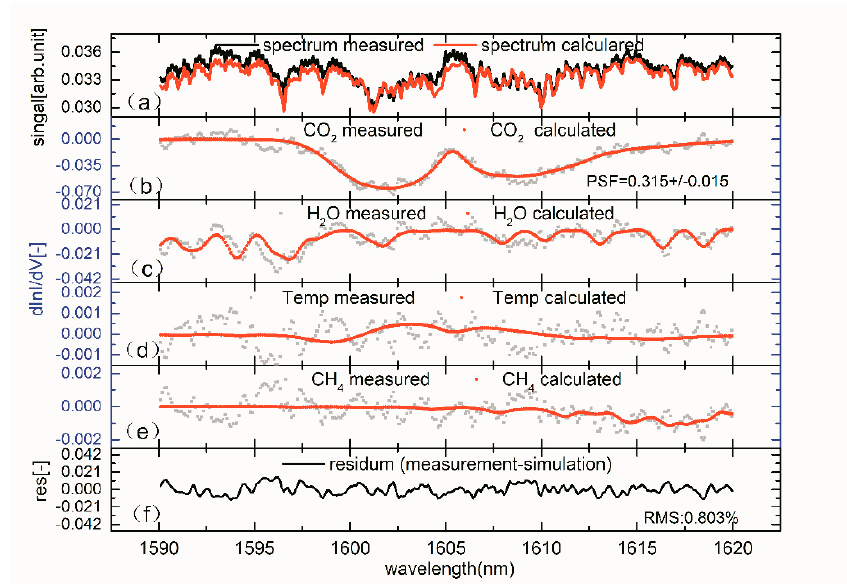
Figure 5. Example of spectral retrieval by WFM-DOAS. ( a ) Shows the pre-processed measurement and the fitted sun-normalized model. The bottom panel ( f ) shows the fitting residuum, which is the difference between the measurement and model after the fit. The second panel ( b ) shows the CO 2 fit. The solid line is the scaled derivative of the radiance with respect to a change in the CO 2 vertical column. The black dashed line shows the CO 2 fit result, which is identical to the red curve plus the spectral fitting residuum; ( c ), ( d ) and ( e ) show the same as (b), but for the interfering H 2 O, Temp, and CH 4 .